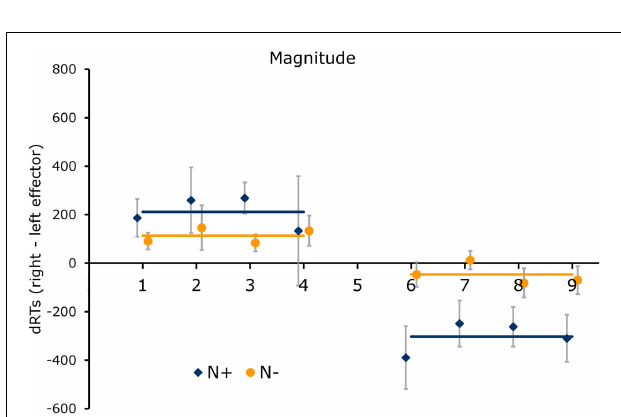
FIGURE 2 | Comparison task. The mean difference in RT between right and left effector responses (dRT) to each number is plotted as a function of numerical magnitude, separately for N + and N − groups.The lines represent the regression fits for each group, computed using a categorical magnitude predictor. Error bars represent ±